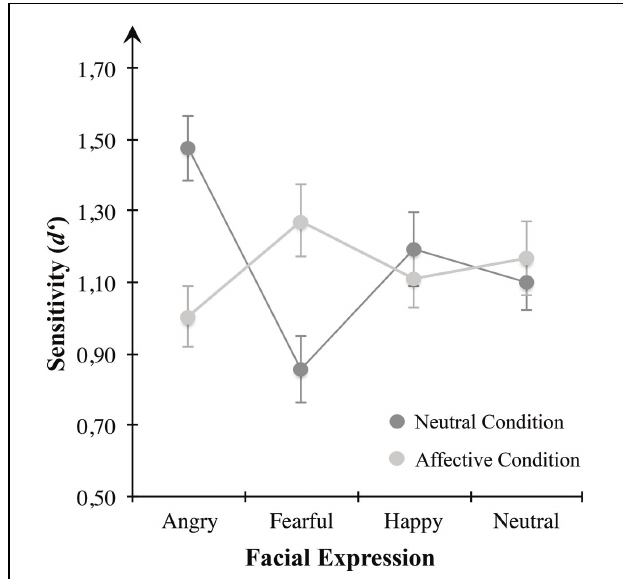
FIGURE 4 | Mean d (cid:2) scores for the mood conditions of Experiment 1. Sensitivity in VWM for emotionally expressive faces is depicted for the affective condition high in defensive motivation (bright gray circles) and the neutral condition (dark gray circles). Error bars depict ± 1